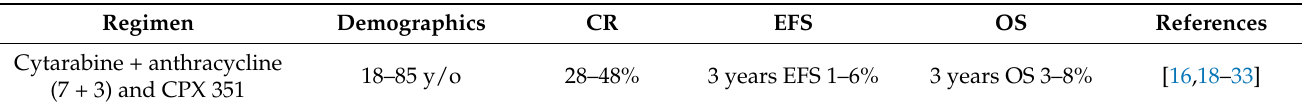
Table 1. Outcome of TP53 -mutated myeloid malignancies patients treated with intensive